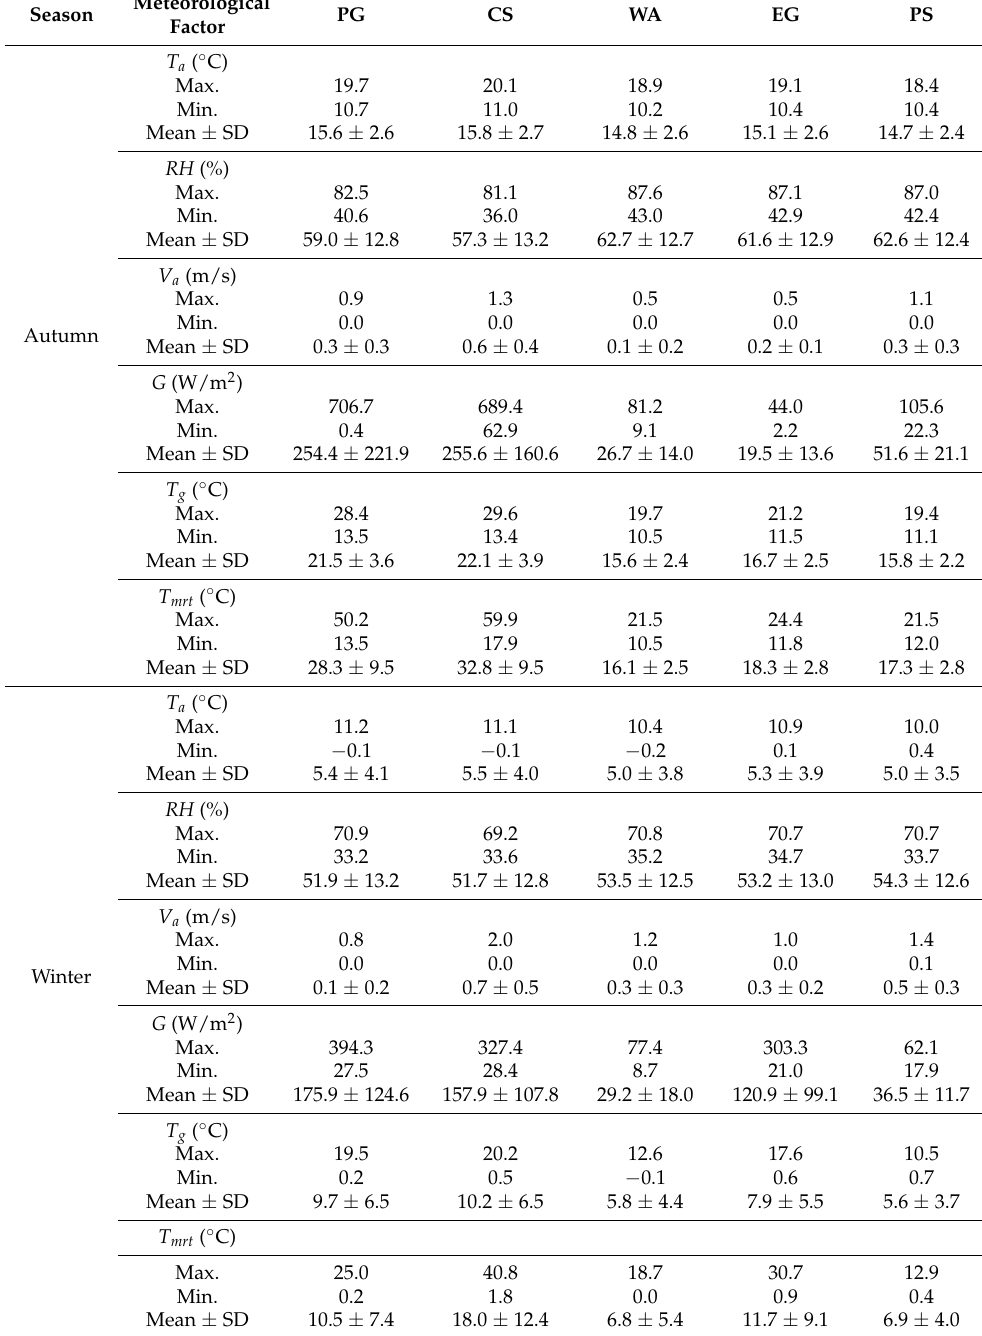
Table 4. Meteorological